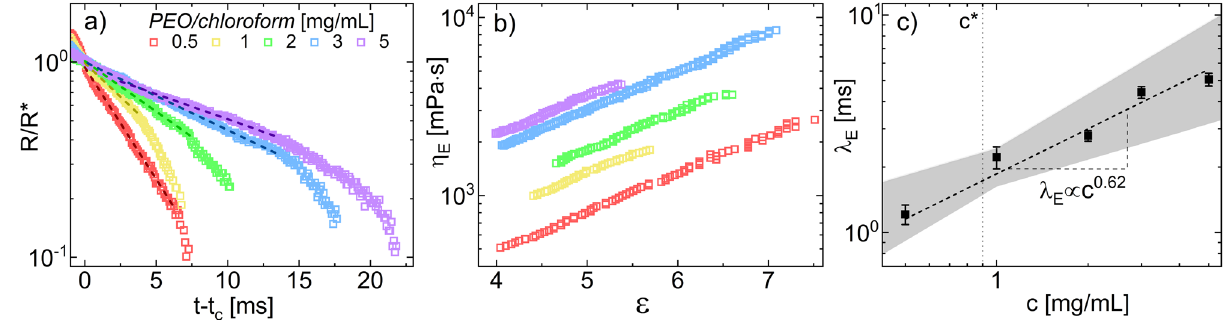
Figure 3. ( a ) Radius evolution, ( b ) extensional viscosities η E , and ( c ) associated relaxation times (cid:31) E for semi-dilute PEO/chloroform solutions. Similar to PEO/water solutions 23 , the EC regime lengthens ( a ) and η E increases ( b ) with increasing PEO concentration. ( c ) Relaxation times scale with concentration as (cid:31) E ∝ c Error bars are the standard deviation across multiple trials; the shaded region reflects the 95% confidence interval around the fit to average